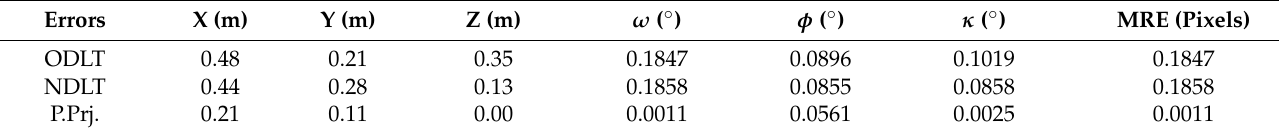
Table 3. Estimated camera EOP errors and mean reprojection errors.